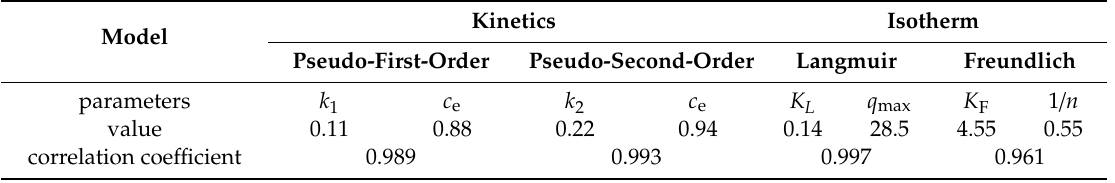
Figure 5. ( a ) Dependence of Cd(II) bulk concentration ( c t ) on contact time, inset shows the adsorption ratio of Cd(II) on ZnO, PDA / ZnO, and DMSA / PDA / ZnO; and, ( b ) the data fitted to the pseudo-first-order ratio of Cd(II) on ZnO, PDA/ZnO, and DMSA/PDA/ZnO; and, ( b ) the data fitted to the pseudo-first- and pseudo-second-order kinetic model. order and pseudo-second-order kinetic model. Table 2. Results for the fit of adsorption kinetics and adsorption Table 2. Results for the fit of adsorption kinetics and adsorption isotherm.